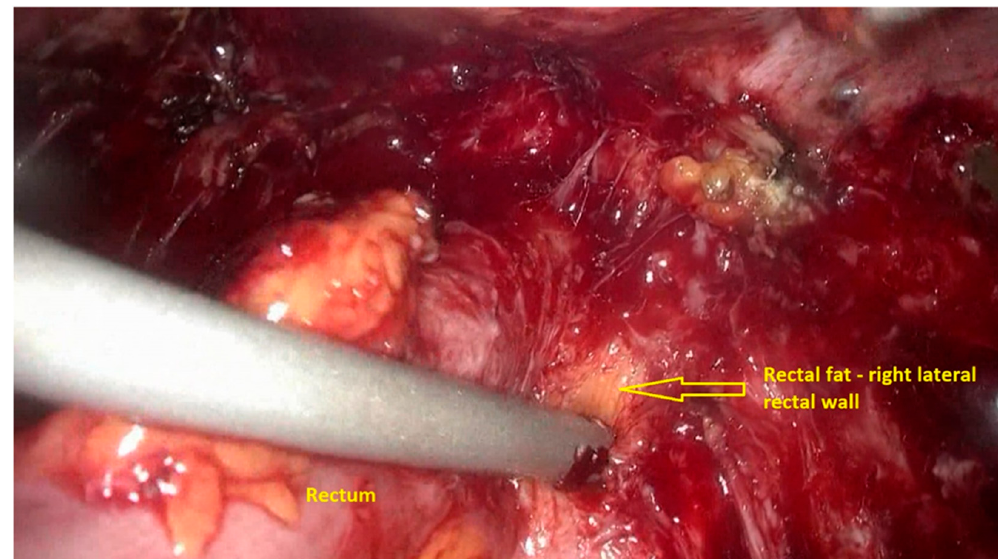
Figure 4 . Dissection and removal of the fat tissue on the left lateral rectal wall .